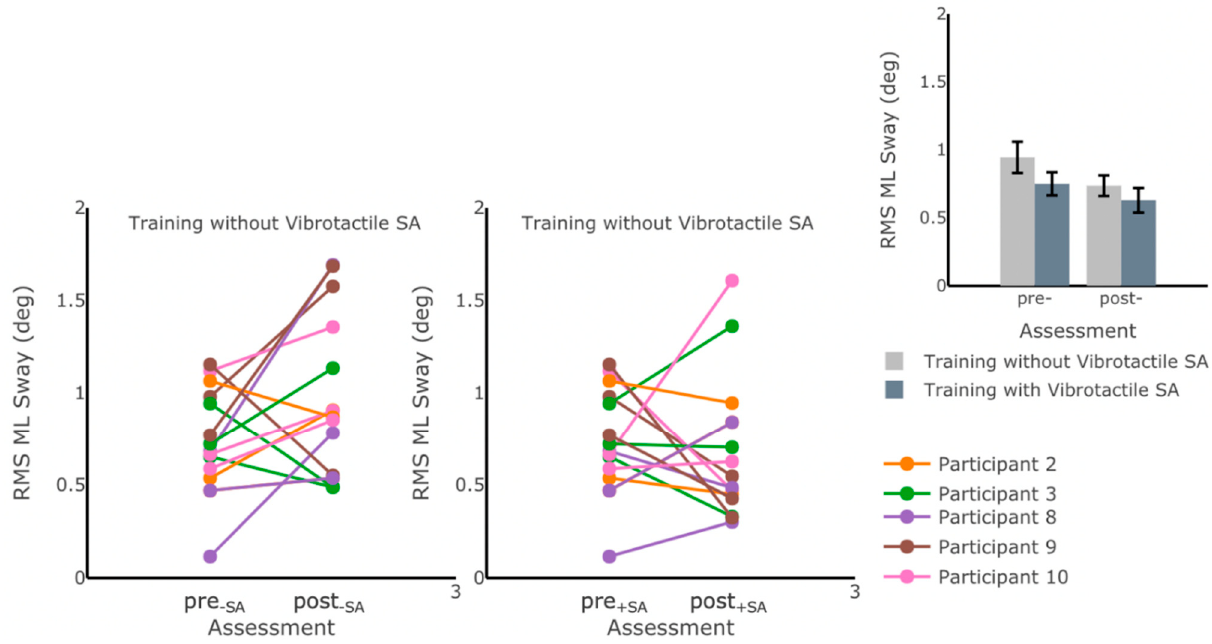
Figure 8. RMS ML Sway measured while participants were standing on foam with eyes open before ( pre + ) and after ( post + ) each of the six-week training blocks. No statistically and after each of the six-week training blocks. No statistically significant differences in postural SA , pre − SA SA , post − SA stability measures were captured through IMU-based kinematic features ( p > 0.05). The main plots significant differences in postural sway measures were captured through IMU-based kinematic show individual trends for the participants’ RMS ML Sway values and the inset shows the average features ( p > 0.05). The main plots show individual trends for the participants’ RMS ML Sway values RMS ML Sway values before and after training for each training block. Error bars on the bar plot and the inset shows the average RMS ML Sway values before and after training for each training indicate SEM values. Participants 1 and 6 were excluded due to missing data. block. Error bars on the bar plot indicate SEM values. Participants 1 and 6 were excluded due to missing